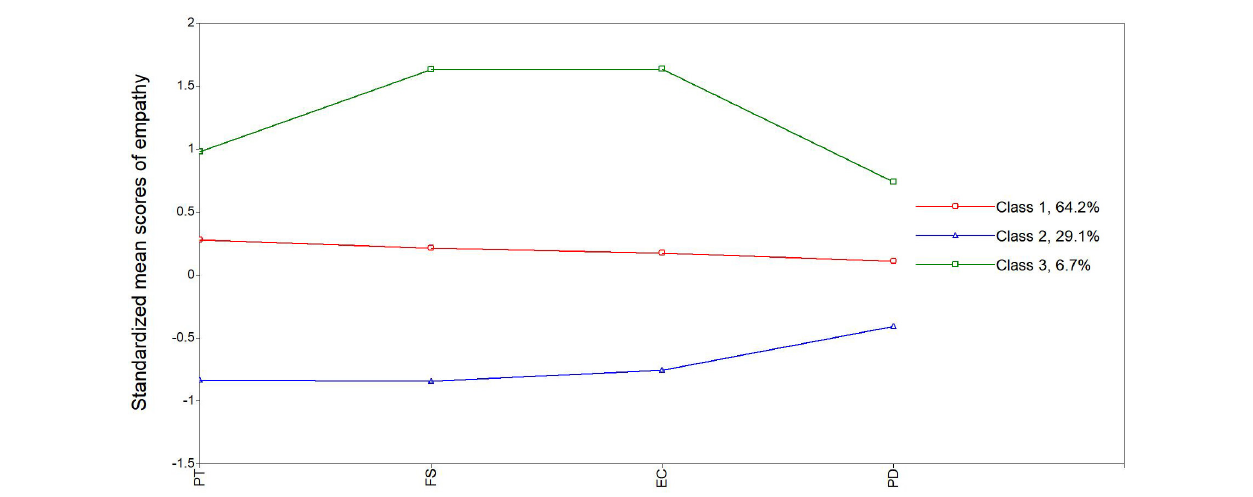
FIGURE 1 | Plot of the standardized mean score of empathy across the three identified latent profiles among nursing students. PT, perspective-taking; EC, empathic concern; PD, personal distress; FS, fantasy.